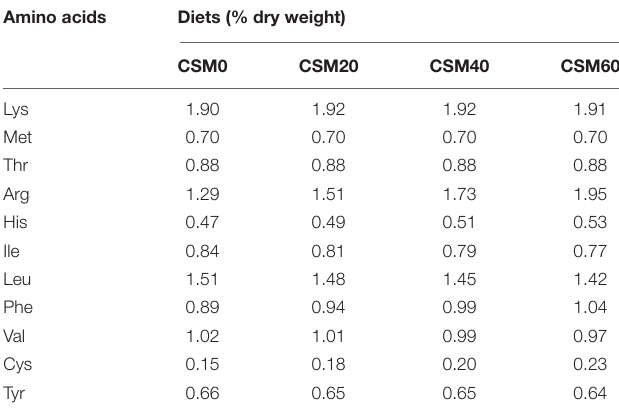
TABLE 2 | The essential amino acids composition of the experimental diets. Amino